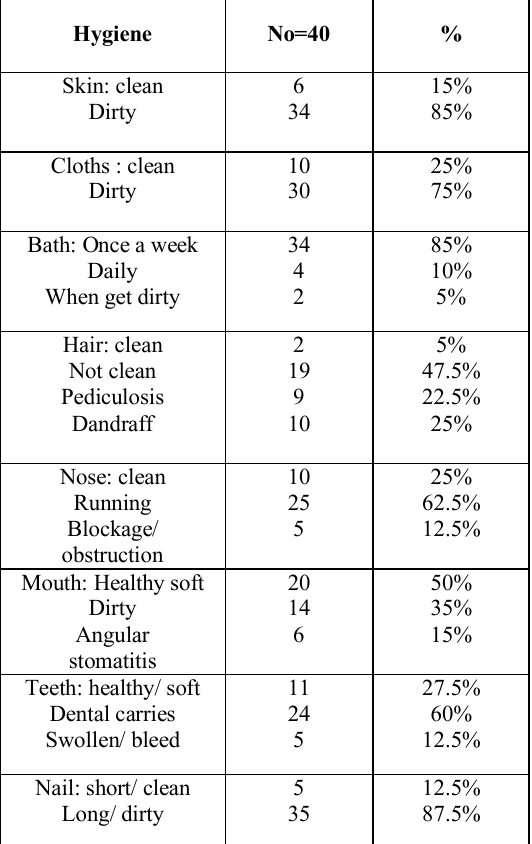
Table 4, states that half of the